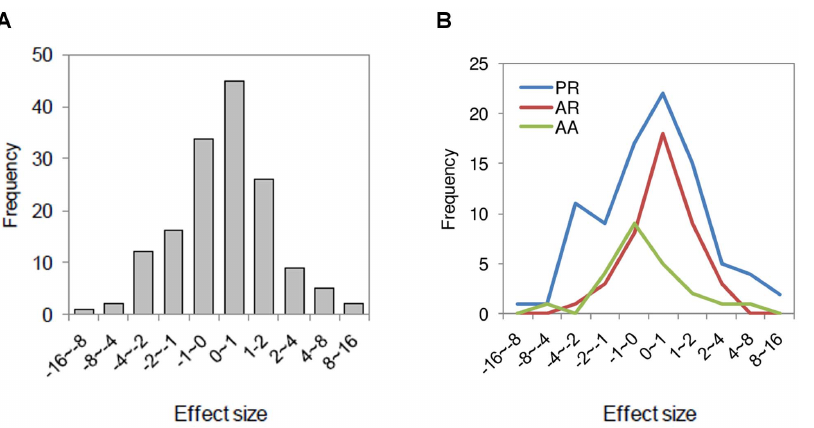
Figure 3. Frequency distribution of effect sizes for plant species richness, animal species richness and animal abundance (A) together and (B) separately. Mean difference effect size, g, and a mixed (random) effects model were used (PR – plant species richness; AR – animal species richness; AA – animal abundance).